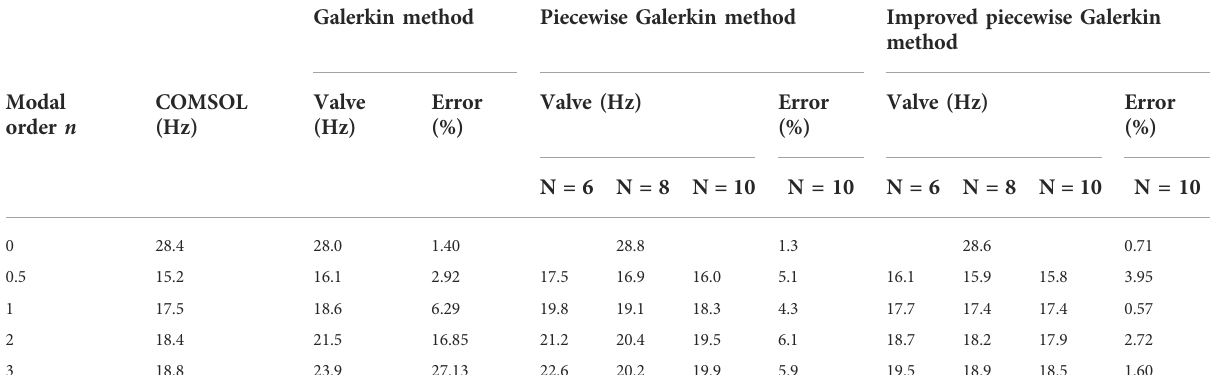
TABLE 2 Natural frequencies of the variable cross-sectional